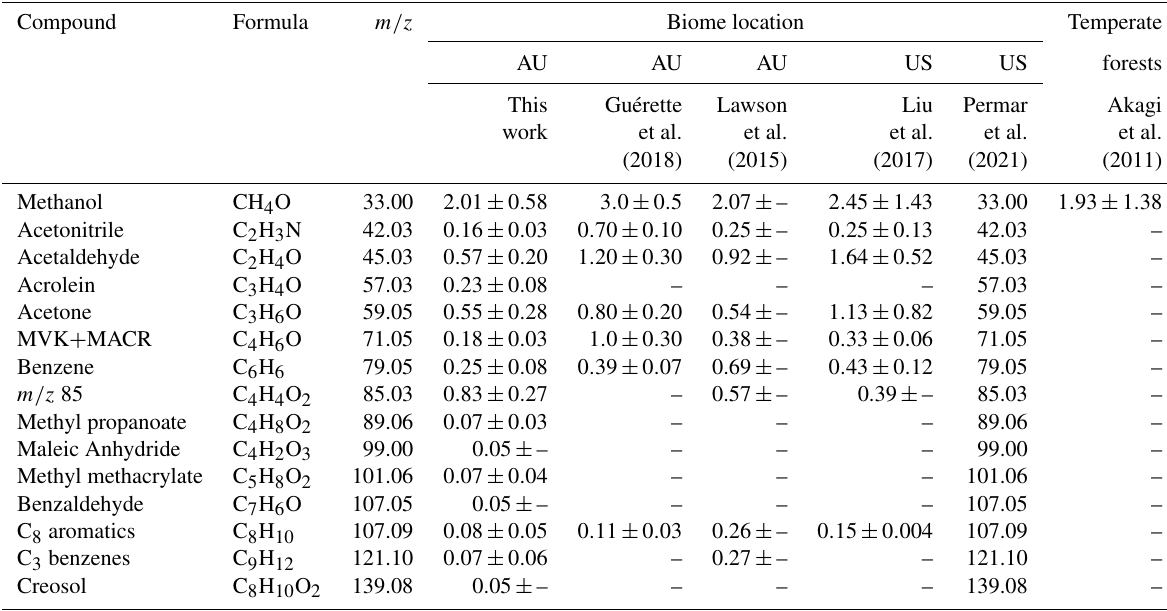
Figure 5. Example ER analysis (a) using acrolein, wherein the smoke event is partitioned into four periods over the evening. Average ERs (slopes) from periods A–C agree closely with those in the freshest portion of the plume (D). Panels (b) and (c) show the singular ERs derived for CO 2 and CH 4 using the entire nighttime dataset (A–D). Table 1. EFs (gkg − 1 ) derived in this work compared to two studies conducted in the same or near temperate Australian forests, two US- based aircraft campaigns sampling western temperate US fuels, and one study reporting EFs across geographically distant temperate forests. Again, m/z 85 indicates the sum of furanone and cis-2-butenediol.